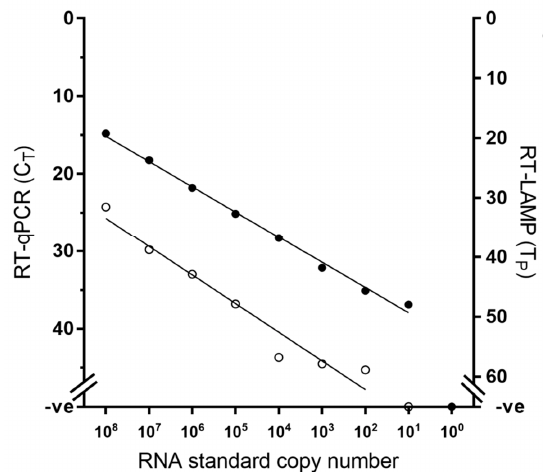
Figure 1. Comparative analytical sensitivity of peste des petits ruminants virus RT-LAMP (open circles) and the gold standard RT-qPCR (closed circles) using in vitro transcribed RNA standards.